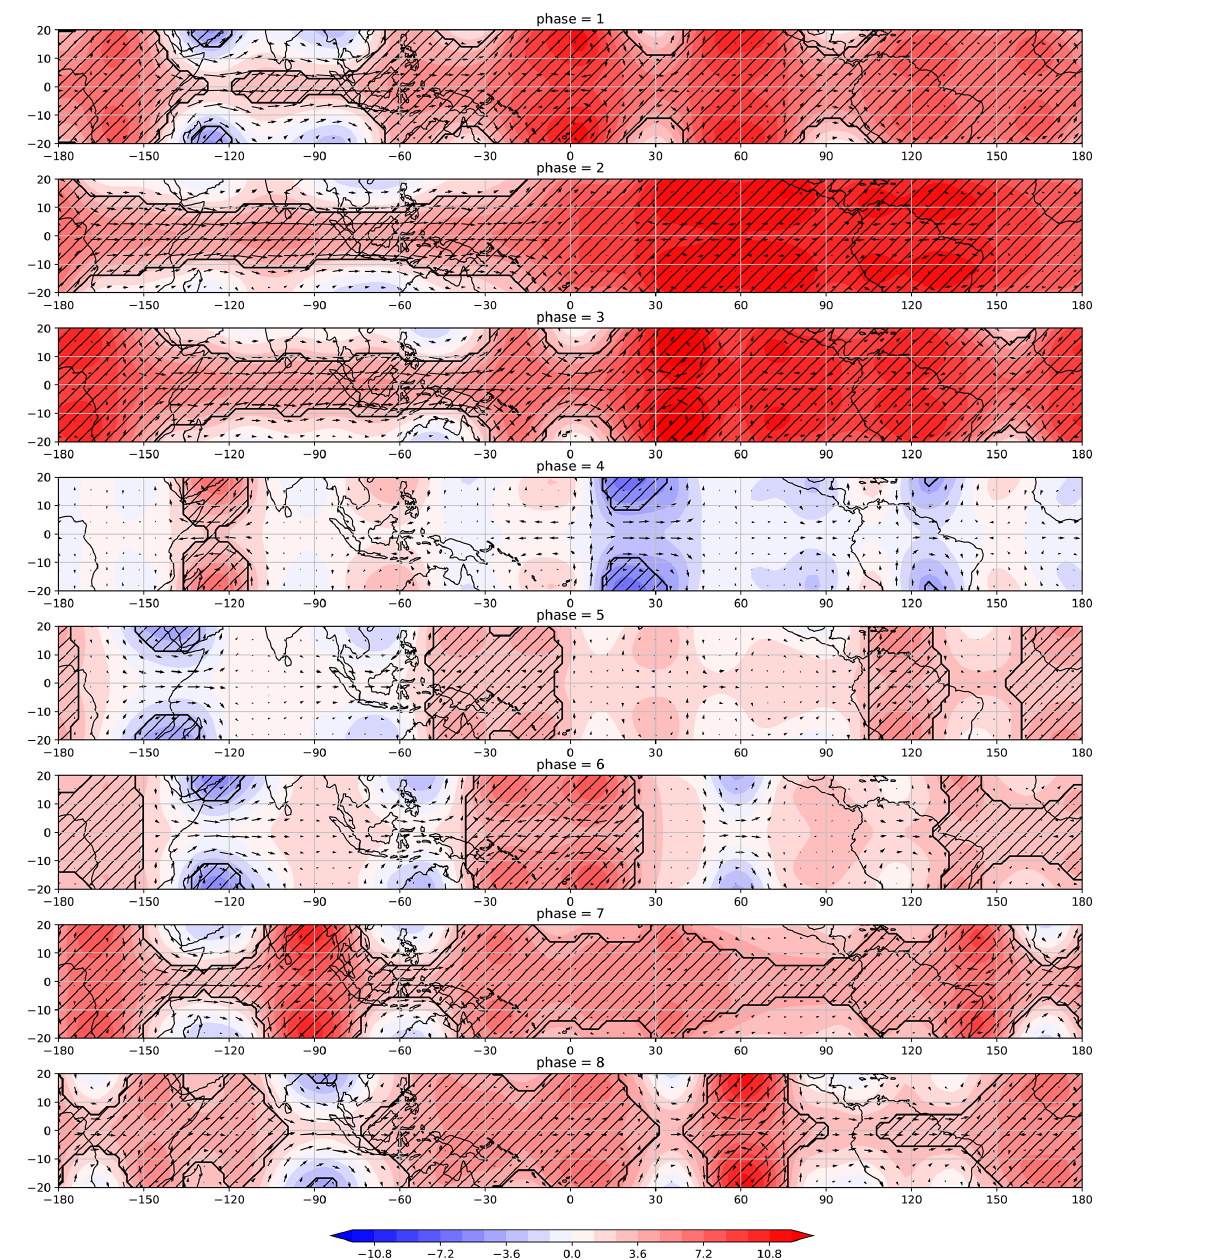
Figure 12. Difference between the velocity and geopotential height fields associated with ROT modes with SZW30 + and SZW30 − . The hatched region corresponds to a significant difference of the geopotential height values under the 5% confidence